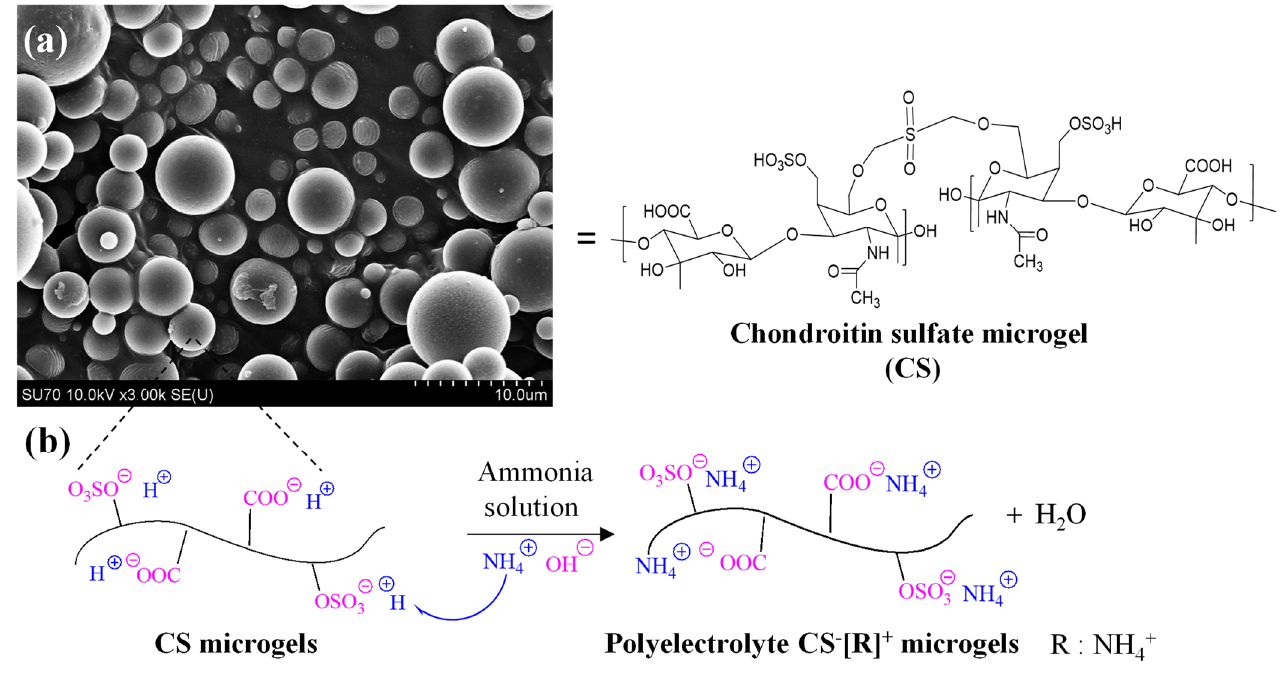
Figure 1. ( a ) SEM images of chondroitin sulfate (CS) microgels and ( b ) schematic representation of preparation of polyelectrolyte CS - [R] + microgels via treatment with ammonia solution. [R = NH 4+ ].